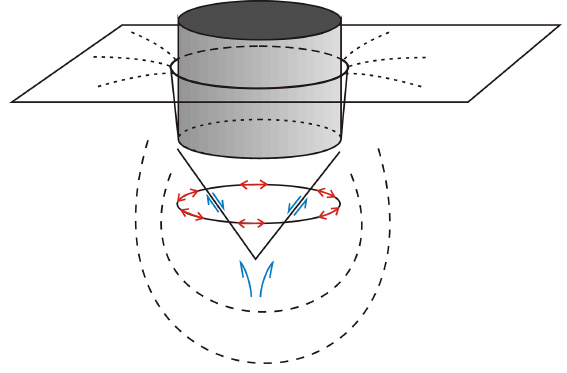
Figure 13. Scheme visualizing strain field during indentation, gov- erned by superposition of shear (blue arrows) in a plane containing indenter axis and extension (red arrows) tangential to the perime- ter of the cone when viewed in a plane normal to the indenter axis. Note that for a given volume element, stress state and incremental strain progressively change during indentation, and that the final mi- crostructure results from stages continuously superimposed during non-coaxial deformation.